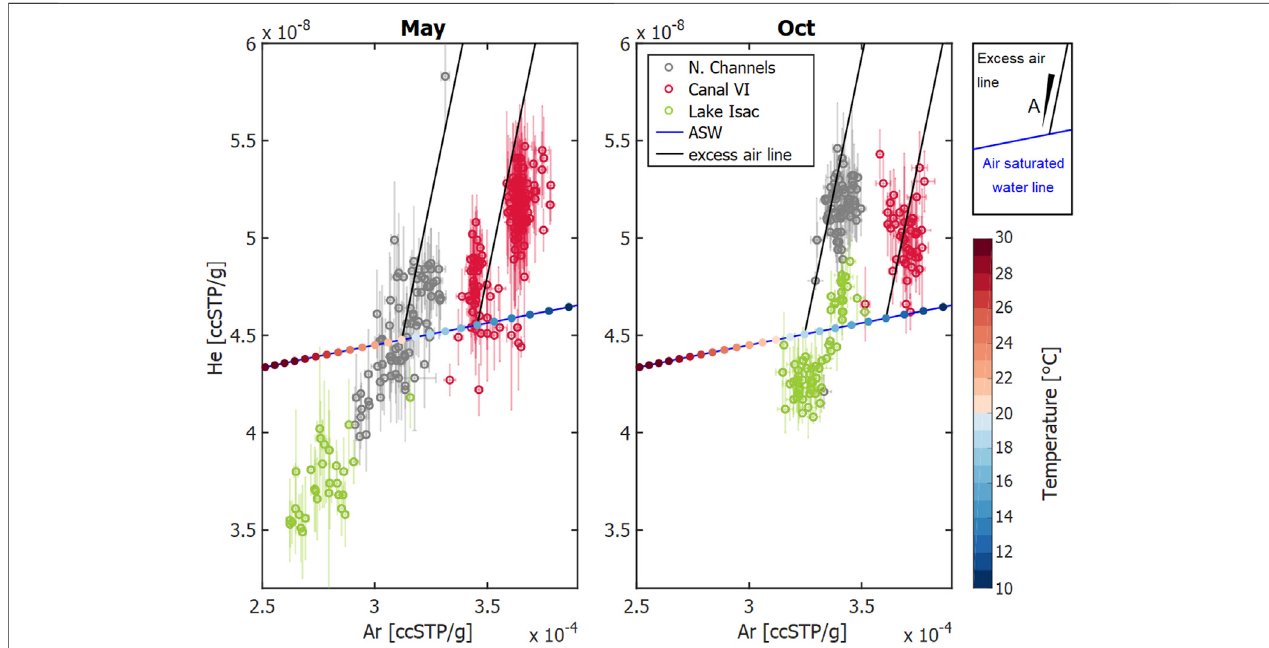
FIGURE8| Hevs.ArconcentrationinccSPT/g,i.e.,cubiccentimeterofgasatstandardpressureandtemperaturepergramofwaterinsamplesfromtheindicated locationsinMayandOctober2017.Theopen circlesshowtheaveragedatafromdifferentobservationsites, standarddeviationsareshown aserrorbars.Thebluelines representtheconcentrationsinair-saturatedwater(ASW)atdifferenttemperatures;withtemperaturein ° Crepresentedascolor-codeddotsat1 ° Cincrements.Thesolid black lines represent the excess-air lines for temperatures that fi t well with the measured data: T = 20 ° C and T = 15 ° C (May), and T = 18 ° C and T = 13 ° C (Oct). The amount of dissolved air, A, increases with increasing distance from the ASW